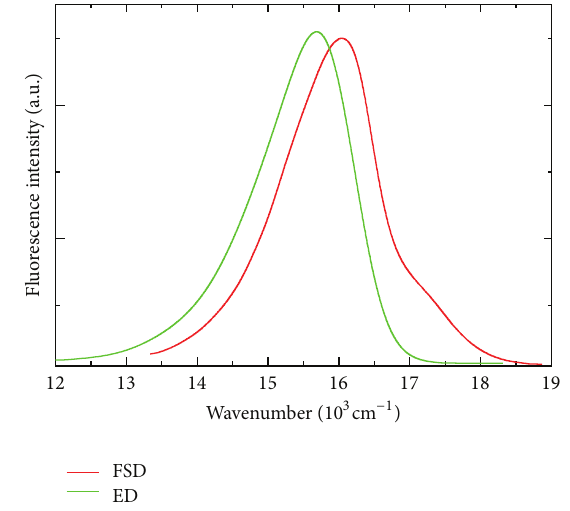
Figure 8: A representative plot of the wavenumber dependence of edge detected (ED) and front surface fluorescence (FSD) detecting fluorescence spectra measured for design (1) TLSC sample doped with 1wt% nanosilica.